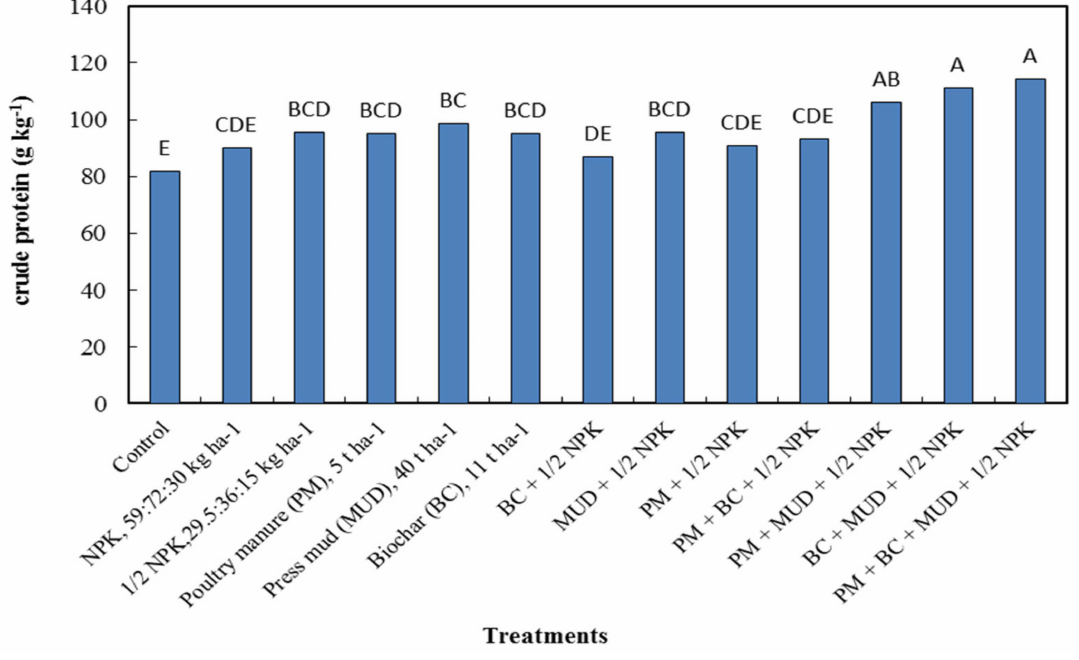
Figure 1. Effect of organic and inorganic amendments on crude protein of forage sorghum under the field conditions at Layyah, Pakistan. Values are the means of two years and three replicates. Means with similar letters at the top of the bar did not differ significantly at p ≤ 0.05 (HSD =